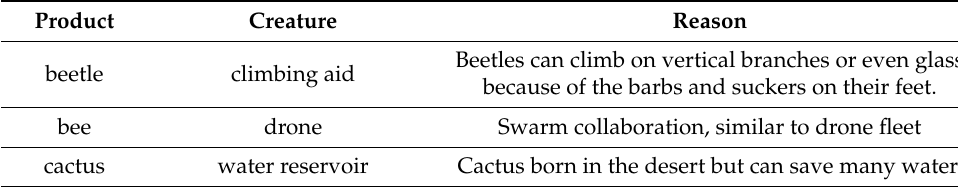
Table 8. Creature function- product function reasoning (27 times).